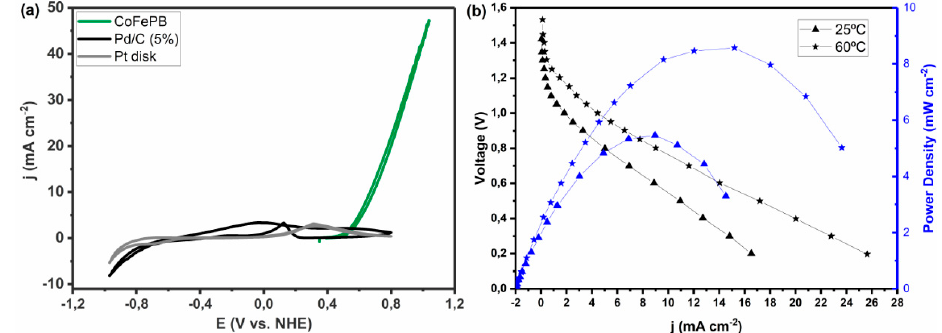
Figure 11. ( a ) Cyclic voltammetry of CoFePB compared to Pd and Pt; ( b ) polarization curve and power density of formate/Ce+4 fuel cell FC2 at 25 °C and 60 °C. Anode: CoFePB/FTO; Anotlyte: 2 M HCOO − (pH 13); Cathode: Carbon felt; Catholyte: 1M HNO 3 (pH 0). Figures reprinted with permission, copyright to ( a ) JACS and ( b ) RSC.